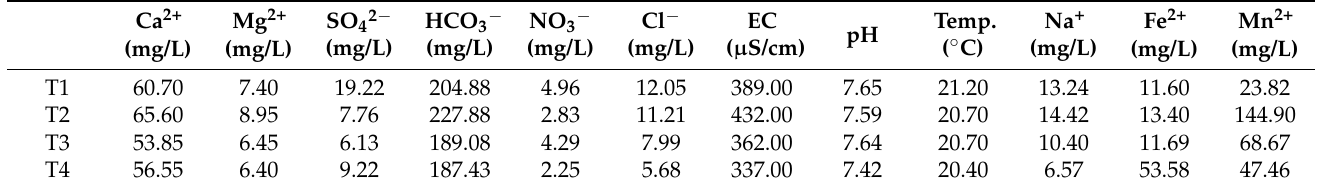
Table 5. Data of the major chemical constituents from the main four drainage canals (May 2019).